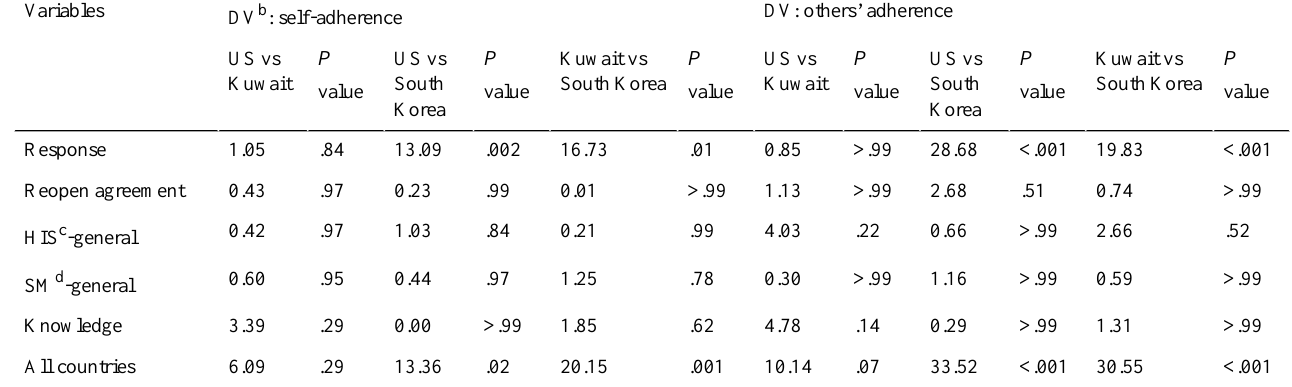
DV: others’adherenceDV b :